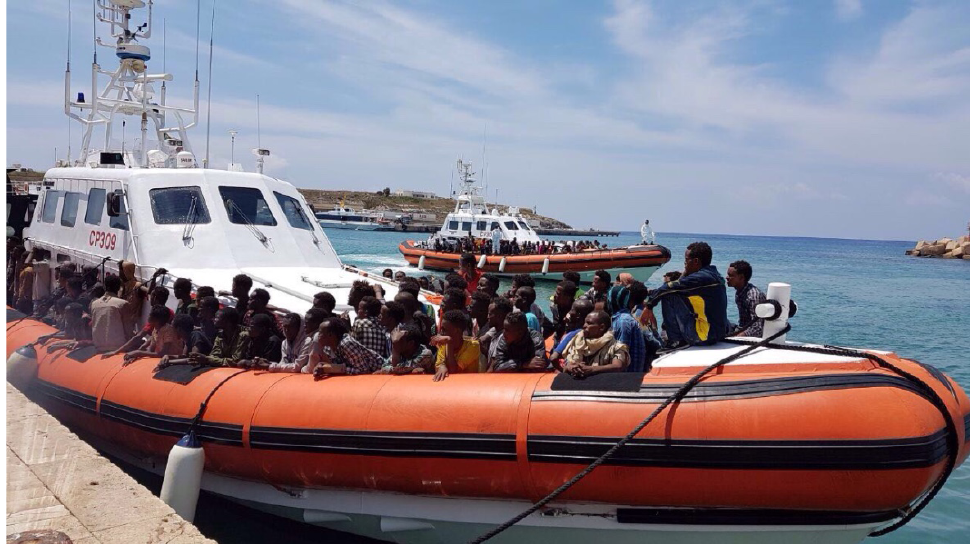
Figure 3. Lampedusa, May 2017. Used with permission from Red Cross Volunteer. refugees, most of them from various African countries, their black skin immediately marking them as strangers, outsiders, noncitizens (see Fanon, 2008), in contrast to the white Red Cross